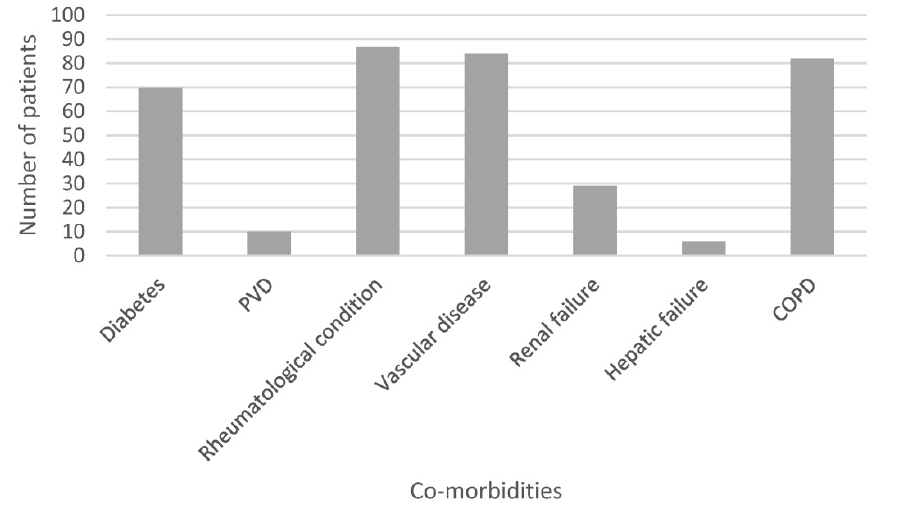
Figure 2: Bar chart showing the prevalence within the cohort of each co-morbidity associated with an increased risk of